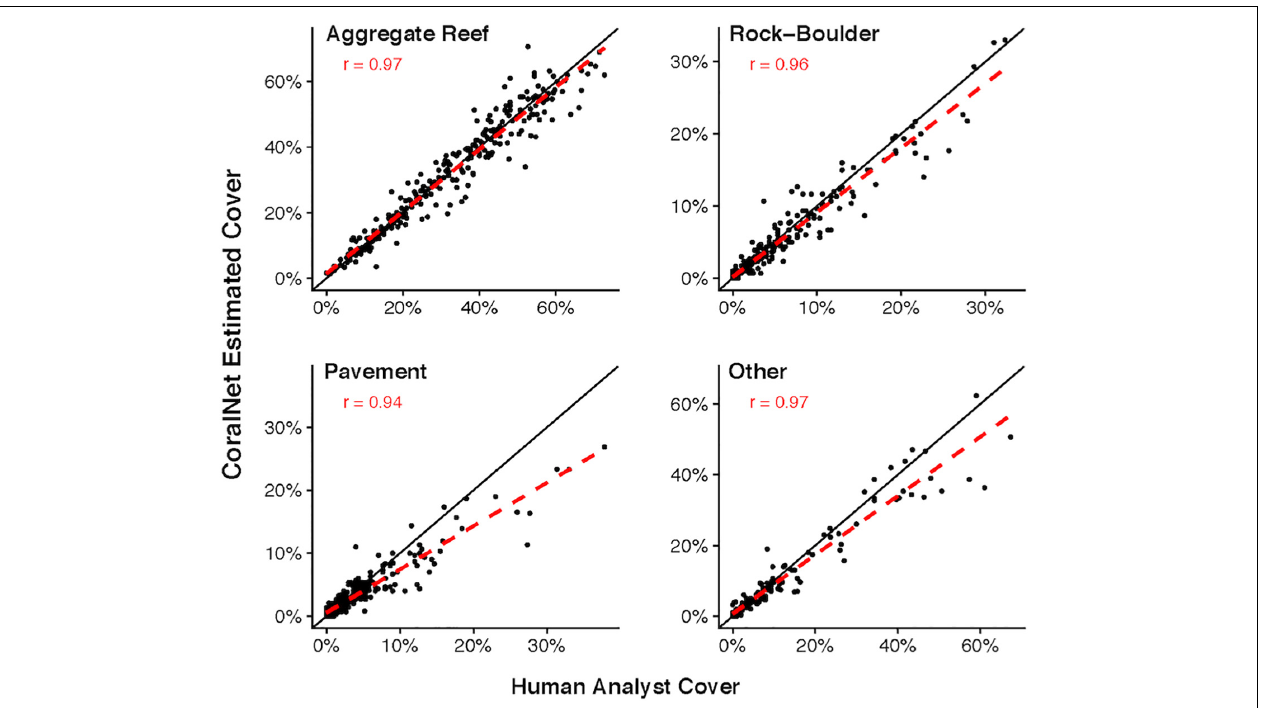
FIGURE 3 | MHI Site-level coral cover by human analysts and CoralNet within different habitat types. Each point represents a single site; the solid black line is the 1:1 line, and the dashed red line is a linear fit of the point data. Results are for CoralNet trained using the “BASE” classification ( Supplementary Table S2 ). “r” values are Pearson’s correlation coefficients. Number of sites per habitat type are: 188 for aggregate reef; 167 for pavement; 159 for rock-boulder; and 84 for other habitats. Correlations are significant ( p < 0.0001) in all